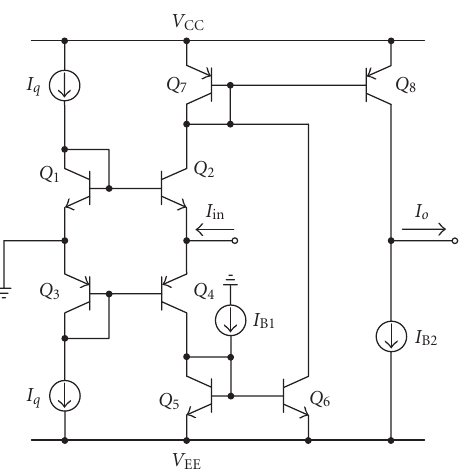
Figure 2: Absolute value